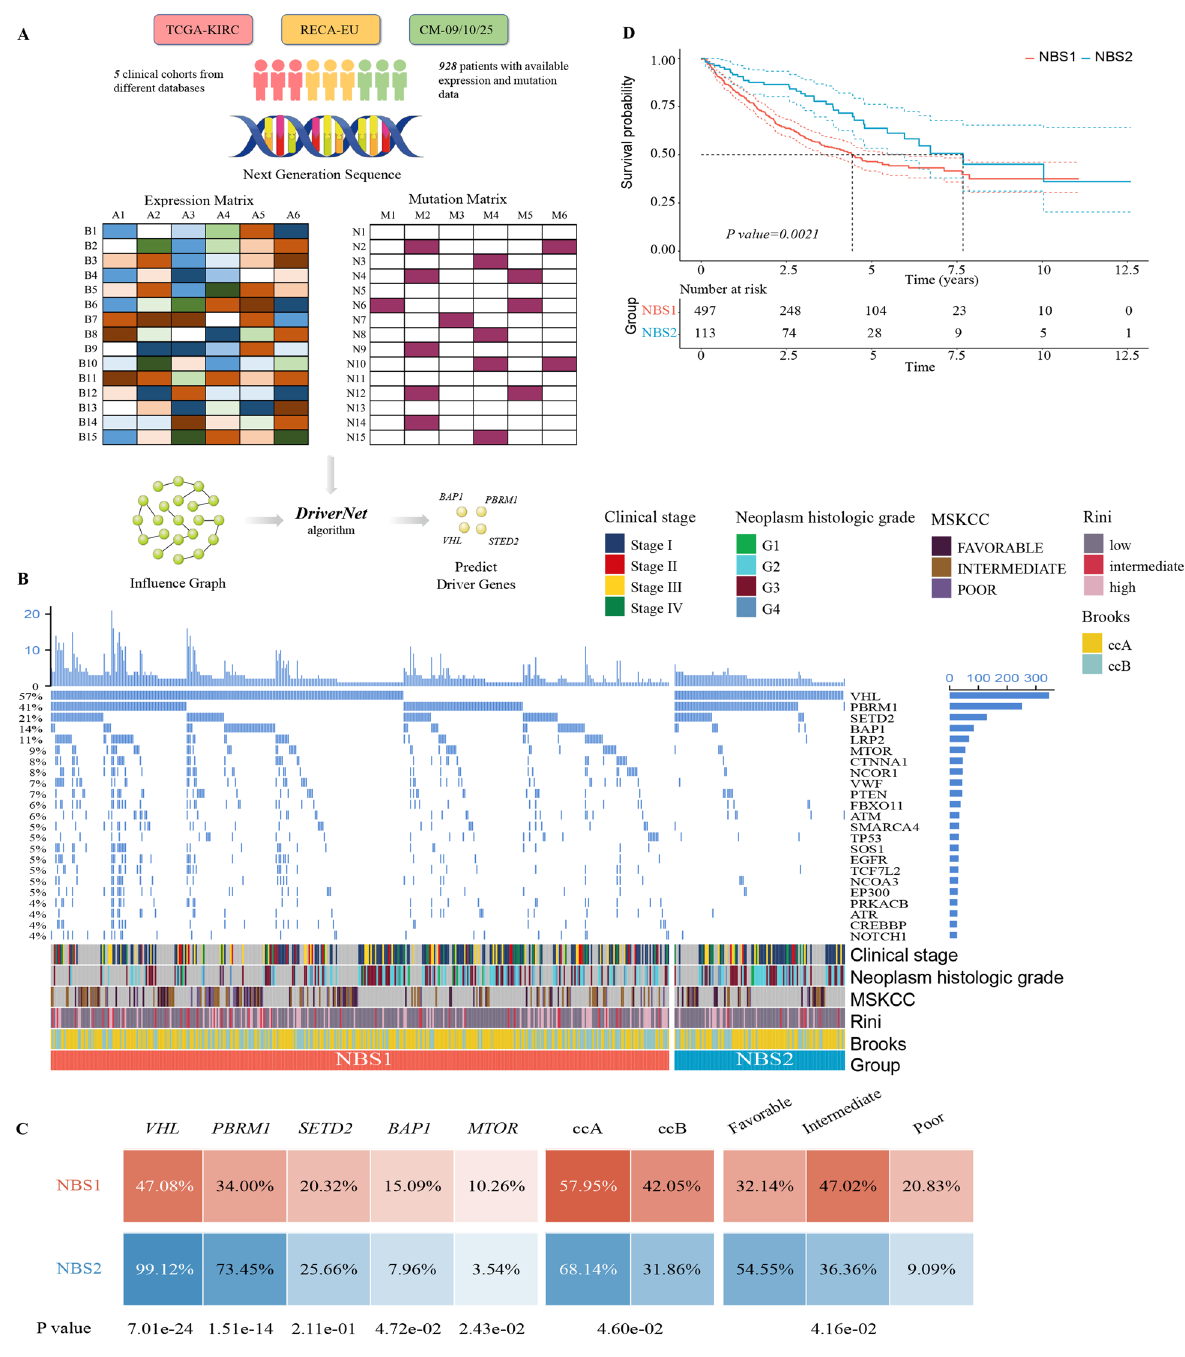
Figure 2. Identifying driver genes and subclass characteristics in clear cell renal cell carcinoma. ( A ). Overview of driver genes identification via DriverNet analysis in clinical cohorts. ( B ) The mutation profiles of subclasses classified by network-based stratification (NBS). Characteristics of clinical stage, histological grade, previously reported transcriptome-based molecular subclasses (MSKCC, Rini and Brooks) between two subclasses were presented simultaneously. ( C ) Difference in mutation frequency of driver genes, molecular characteristics stratified by Brooks and MSKCC between two subclasses. Fisher’s exact tests were applied to compared the statistical differences. ( D ) Kaplan–Meier survival curve of two subclasses. Statistical difference was calculated by log-rank